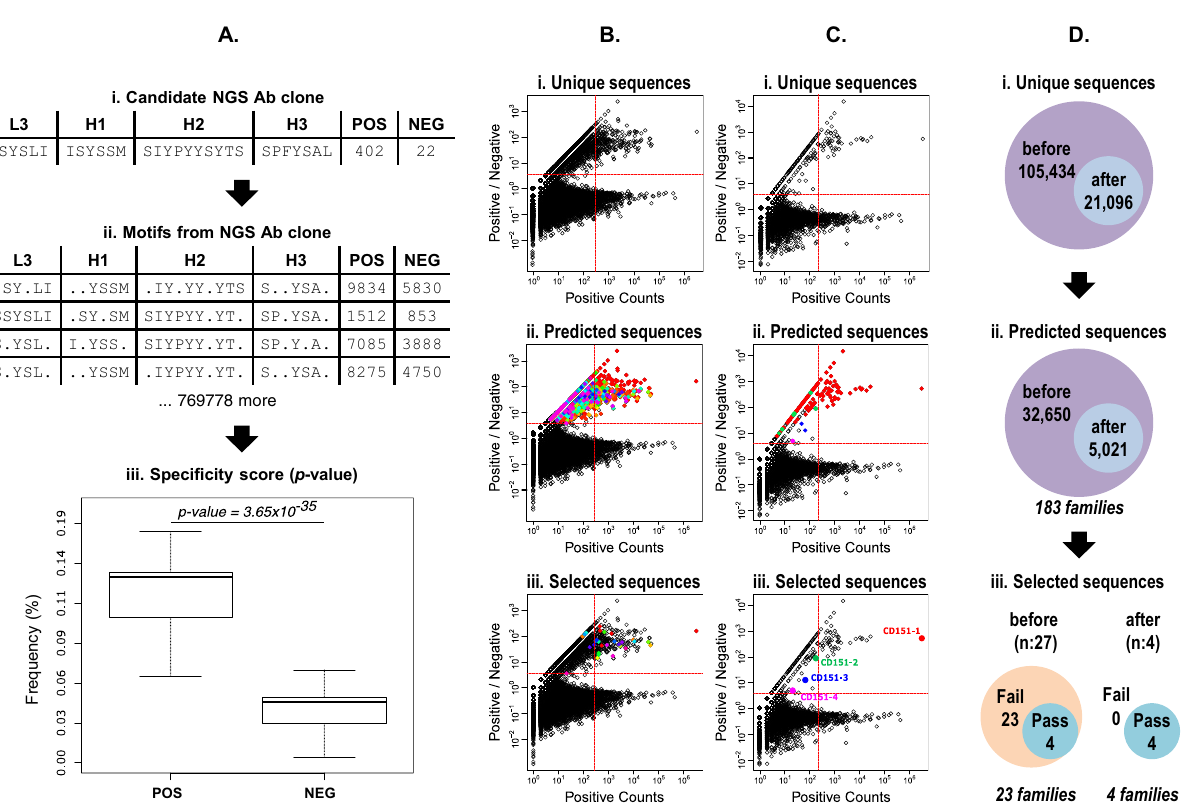
Fig. 4 CellectSeq motif-based Ab discovery strategy of CD151 selective Abs. A Scoring Speci fi city: (i) Consider the candidate antibody NGS clone, the CDR sequences and counts in the positive (POS) and the negative (NEG) selection pools at round 4 are reported. (ii) We enumerate all consensus motifs in the CDR sequences. (iii) We score the binding speci fi city of the candidate antibody by assessing the separation between the distributions of the frequencies of the motifs in the positive (POS) and negative (NEG) pools. To this end, we calculate the p value of the t -test (Methods). B , C In each fi gure, the abundance of each sequence in the positive pool (positive Counts, x-axis) is plotted versus the ratio of the abundance in the positive pool over the negative pool (positive/negative, y-axis). Each circle represents one unique Ab clone, colored circles (except black) represent families of homologous sequences (sequence identity >0.75). The dashed red lines de fi ne an upper-right quadrant that contains enriched Ab clones de fi ned as occurring more than 200 times in the positive pool and being greater than fourfold enriched relative to the negative pool. In contrast to Fig. 3, the dashed red lines here serve only as visual references to inspect the individual enrichment levels of the clones predicted by CellectSeq as highly speci fi c ( p value <10 − 10 ). B Before Filtering: NGS sequences and predicted sequences before fi ltering hybridization errors (N:368,427). (i) Distribution of unique sequences in the positive pool and their enrichment over the negative pool. (ii) Distribution of predicted sequences with high speci fi city ( p value <10 − 10 ), colored by family of homologs. (iii) Distribution of selected sequences for in situ validation, colored by family of homologs. C After fi ltering: NGS sequences and predicted sequences after fi ltering hybridization errors (N:105,434). (i) Distribution of unique sequences in the positive pool and their enrichment over the negative pool. (ii) Distribution of predicted sequences with high speci fi city ( p value <10 − 10 ), colored by family of homologs. (iii) Distribution of selected sequences for in situ validation, colored by family of homologs. Colored circles represent Ab clones named CD151-1 to CD151-4 which were selected and validated as speci fi c CD151 binding Abs by cellular phage ELISA. Clones CD151-2 to CD151-4 are in the top-left quadrant, which means they are outside the scope of the NGS enrichment ranking method. D Before versus After fi ltering: Difference between number of unique sequences and prediction results before and after fi ltering hybridization errors. (i) Number of unique sequences in the positive pool before and after fi ltering. (ii) Number of predicted sequences before and after fi ltering. (iii) Number of validated sequences before and after the fi into 183 distinct families of similar L3/H3 sequences (>80% both the positive and negative pools, we obtained the frequencies identity), whereas after fi ltering the Abs reduced to only four (i.e., number of observations) of L3/H3 pairs, where both CDRs distinct families (Fig. 4Biii, Ciii, Diii). are the most diverse in terms of length and amino acid compo- To experimentally assess the validity of predicted Abs in both sitions in Library F 42 . We calculated a frequency cut-off to scenarios, we selected the Abs with best speci fi city scores ( p determine valid L3/H3 pairs utilizing a minimal occurrence values; Fig. 4Aiii) from each of the four families predicted after threshold, with all invalid pairs fi ltered from the selection pool as fi ltering, as well as 23 additional Abs predicted before fi ltering potential PCR and NGS artifacts (see Methods). We then applied (Fig. 4Biii, Ciii, Diii and Table S1). Due to the low NGS the motif-based in silico Ab discovery strategy to predict CD151 enrichment of the identi fi ed Ab clones, instead of PCR rescue or highly selective binders ( p values <10 − 10 ) for both scenarios, before and after fi ltering (Fig. 4Bii, Cii). The error- fi ltering similar methods 63,64 , genes encoding the 27 candidate Ab clones were synthesized and cloned into expression plasmids to permit eliminated 80% of the unique clones from the positive pool recombinant production of Fab protein from E. coli . After (Fig. 4Bi, Ci, Di). Similarly, the application of the error- fi ltering puri fi cation, we compared the activity of each Fab by fl ow before the motif-based in silico prediction of CD151 clones cytometry for binding to HEK293T-CD151 + cells relative to eliminated 85% of the unique Abs (Fig. 4Bii, Cii, Dii). Interest- HEK293T-CD151 − cells. All four Ab clones predicted after ingly, before error- fi ltering the in silico predicted Abs clustered